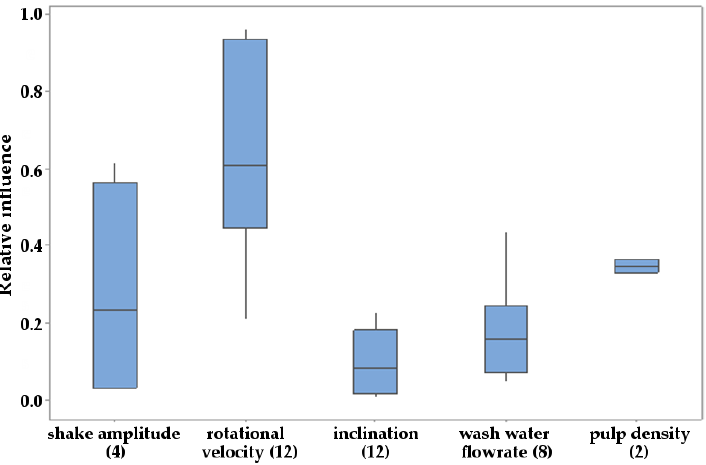
Figure 3. Boxplot of relative importance of operational variables on grade and recovery based on relative change in the adjusted R 2 measure of model fit on removing a variable. Brackets indicate number of data points.